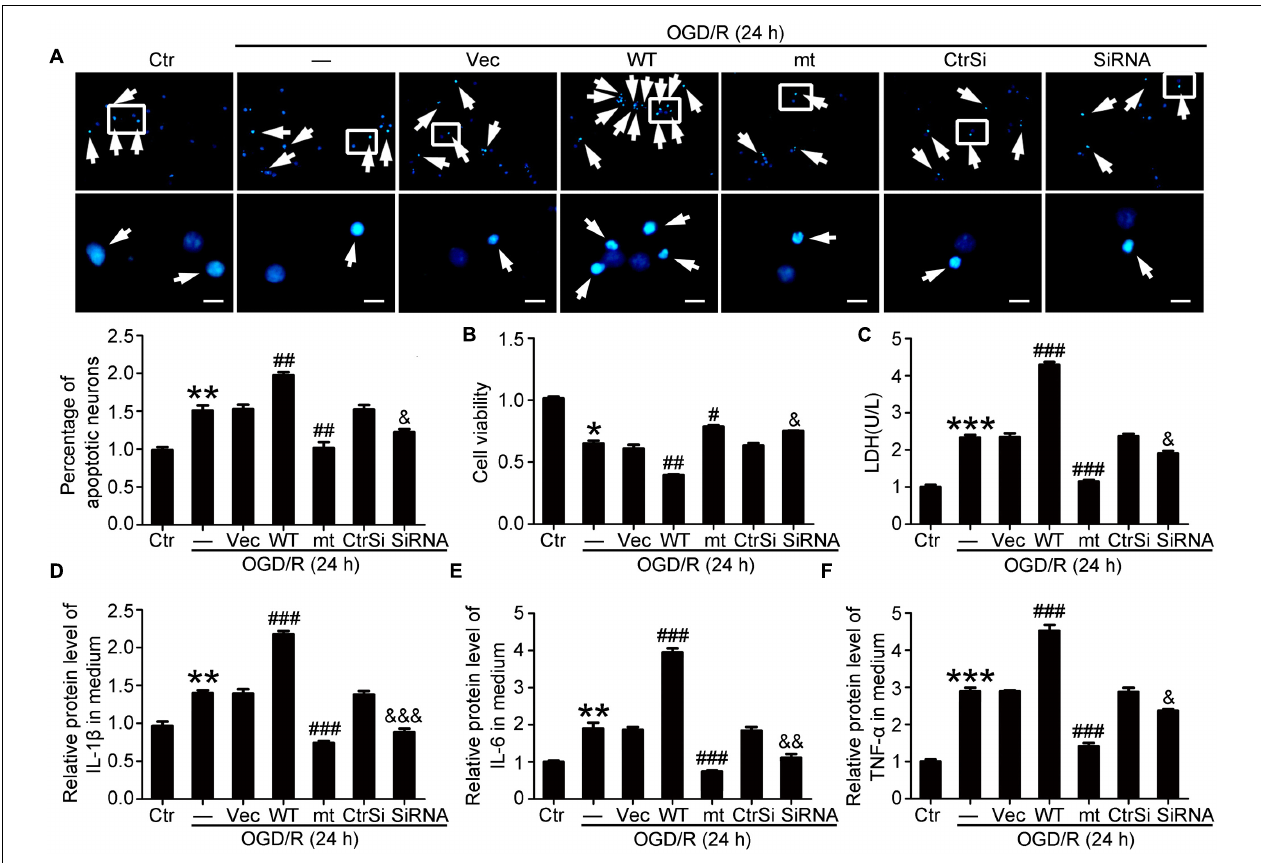
FIGURE 5 | Effects of PEBP1 overexpression and knockdown on neuron apoptosis and inflammatory response in cultured neurons exposed to OGD/R for 24 h. (A) Hoechst 33258 Staining. Arrows indicated the nuclei of apoptotic neurons. Scale bar = 20 µ m. ∗∗ p = 0.0013 vs. control group, ## p = 0.0031 in OGD/R + wide type GFP-PEBP1 group and ## p = 0.003 in OGD/R + GFP-PEBP1 (S153A) group vs. OGD/R + vector group, & p = 0.028 vs. OGD/R + control-siRNA group ( n = 3). (B) Cell viability analysis. The mean value for control group was normalized to 1.0. ∗ p = 0.0323 vs. control group, ## p = 0.0042 vs. OGD/R + vector group, # p = 0.024 vs. OGD/R + vector group, & p = 0.028 vs. OGD/R + control-siRNA group ( n = 3). (C) LDH analysis. ∗∗∗ p < 0.001 vs. control group, ### p < 0.001 vs. OGD/R + vector group, & p = 0.018 vs. OGD/R + control-siRNA group ( n = 3). (D–F) ELISA assay of the contents of IL-1 β , IL-6 and TNF- α in culture supernatant. In IL-1 β , ∗∗ p = 0.0054 vs. control group, ### p < 0.001 vs. OGD/R + vector group, &&& p < 0.001 vs. OGD/R + control-siRNA group ( n = 3). In IL-6, ∗∗ p = 0.0043 vs. control group, ### p < 0.001 vs. OGD/R + vector group, && p = 0.0035 vs. OGD/R + control-siRNA group ( n = 3). In TNF- α , ∗∗∗ p < 0.001 vs. control group, ### p < 0.001 vs. OGD/R + vector group, & p = 0.036 vs. OGD/R + control-siRNA group ( n = 3). In (A–F) , the mean values for control group were normalized to 1.0. Statistical comparisons between groups were performed using one-way analysis of variance followed by either a Dunnett’s or a Tukey’s post hoc test, the former